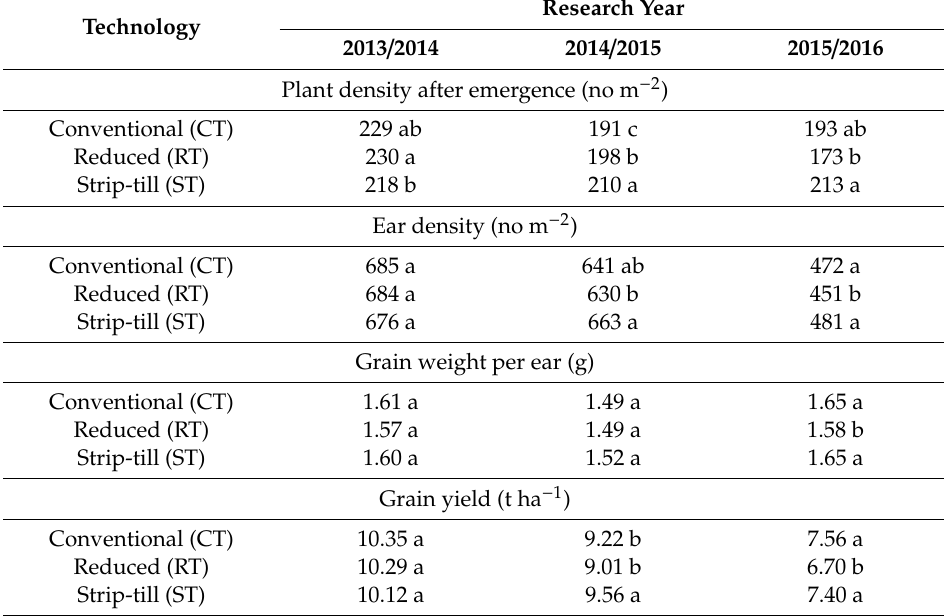
Table 2. E ff ect of technology basic tillage, pre-sowing fertilisation, and winter wheat sowing on the yield components and winter wheat grain yield.